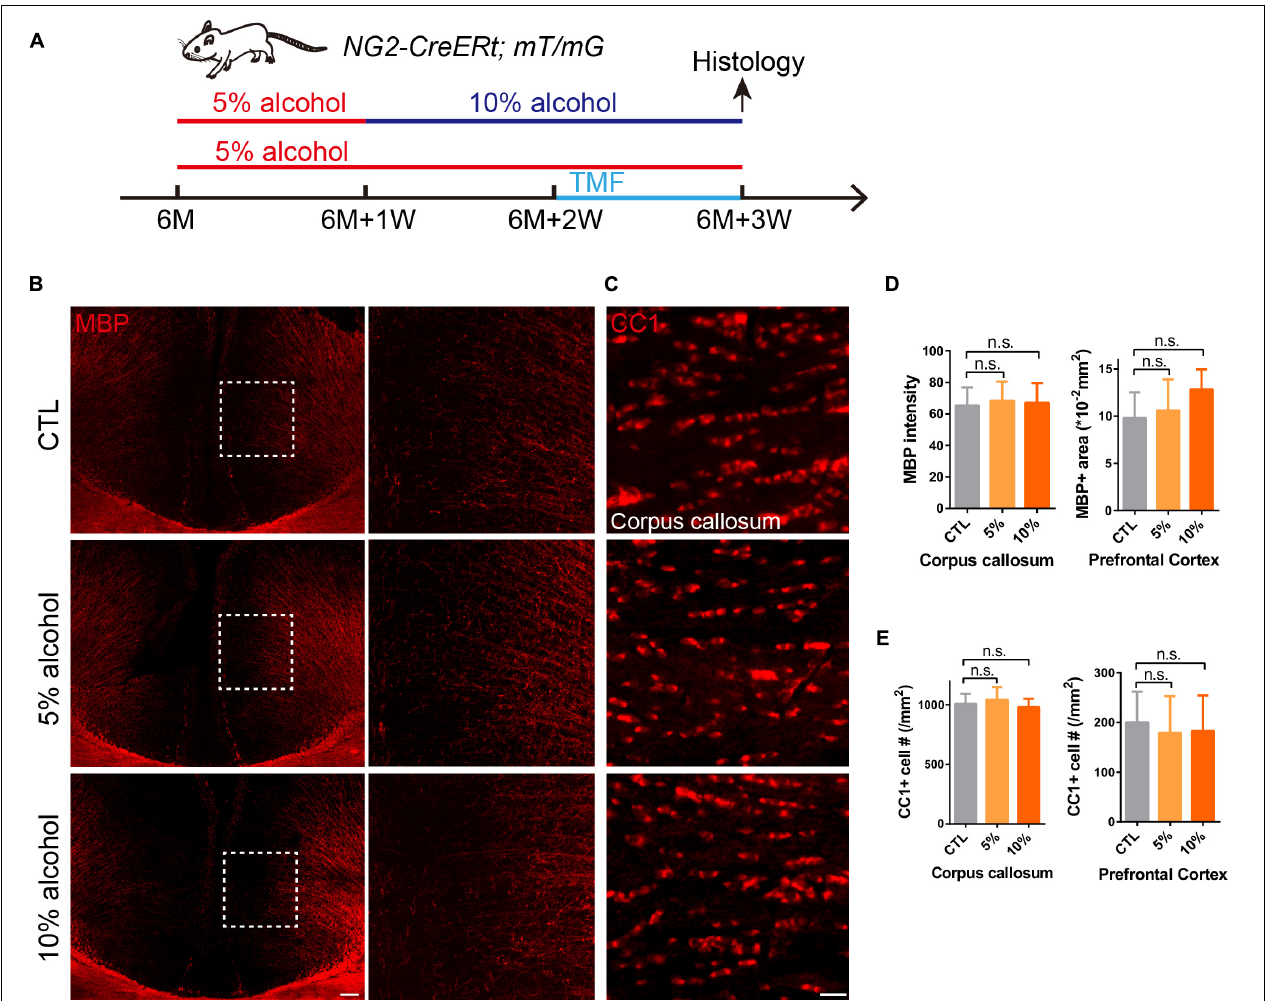
FIGURE 1 | Overall myelin and mature OLs are not affected after chronic alcohol exposure. (A) Schematic diagram displaying the time course for alcohol (5 or 10%) treatment, tamoxifen induction and histology in the NG2-CreERt; mT/mG mice. Note that in the 10% alcohol group, 5% alcohol was administrated in the first week as an adaption step. (B) MBP staining showing intact myelin sheath in the cortex of alcohol treated groups compared to littermate controls. Scale bar 200 µ m. The dotted white box was magnified in the right panel. (C) Immunostaining of CC1 showing comparable number of mature OLs in the corpus callosum of mice in alcohol treated and CTL group. Scale bar 20 µ m. (D) Quantification of MBP + area and MBP intensity in the prefrontal cortex and corpus callosum, respectively (n.s. p = 0.32 and 0.95, n = 4). (E) Quantification of CC1 + cell number in the corpus callosum and prefrontal cortex (n.s. p = 0.85 and 0.47, n =